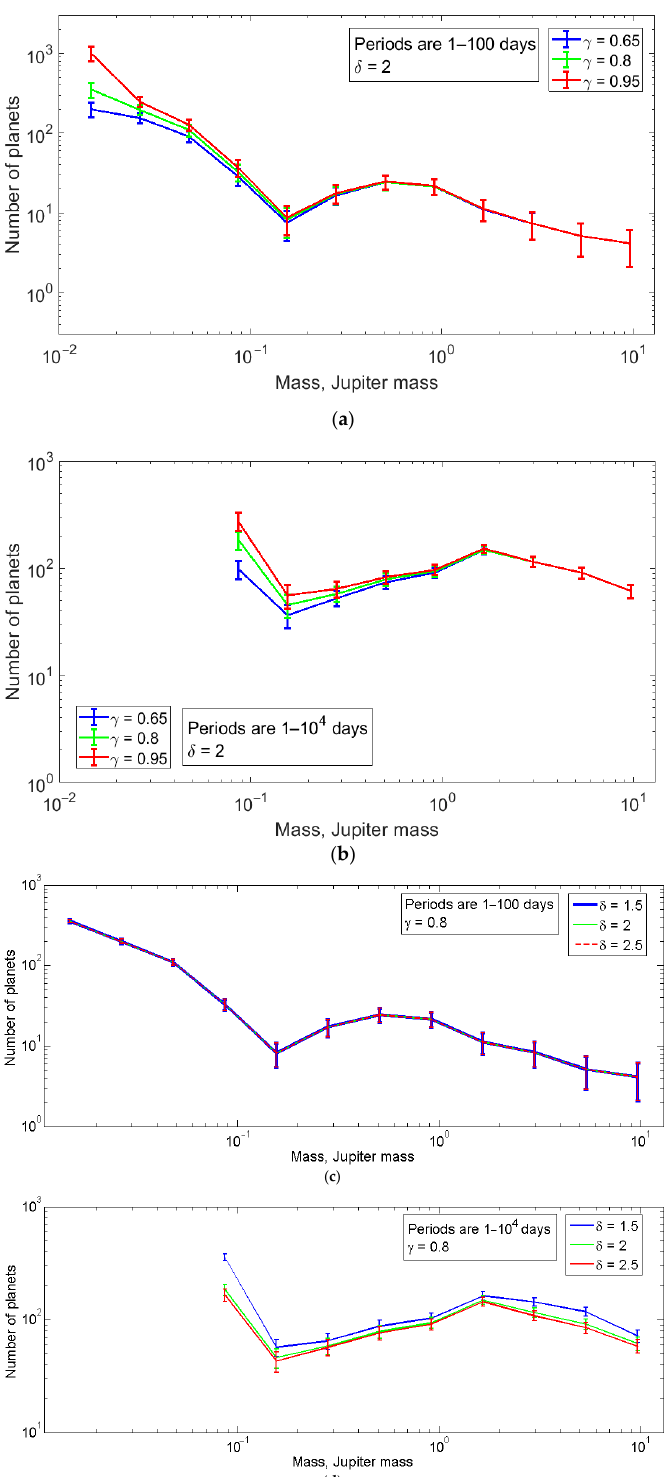
Figure 5. The corrected (de-biased) mass distributions of planets N ( m ). The coefficients are set at δ = 2.0 and γ = 0.65, 0.8, and 0.95 for the planets with m = (0.011 − 13)M J and P = 1 − 100 days (panel ( a )) and with m = (0.065 − 13)M J and P = 1 − 10 4 days (panel ( b )). The coefficients are set at δ = 1.5, 2.0, and 2.5 and γ = 0.8 for the planets with m = (0.011 − 13)M J and P = 1 − 100 days (panel ( c )) and with m = (0.065 − 13)M J and P = 1 − 10 4 days (panel ( d )). The error bars were estimated according to the Poisson distribution.